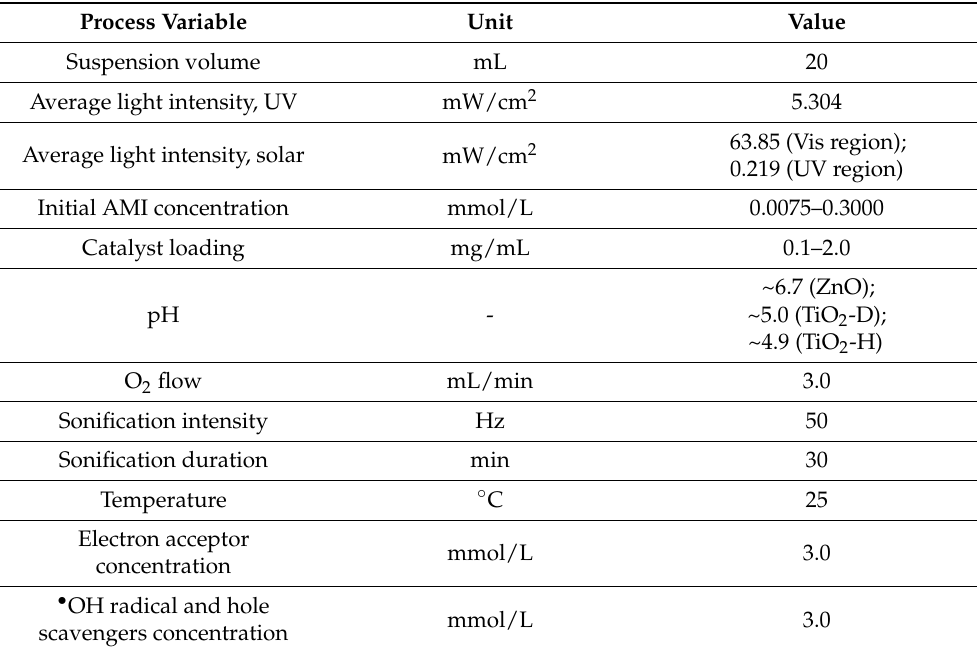
Table 2. Operational variables applied during photocatalytic degradation of